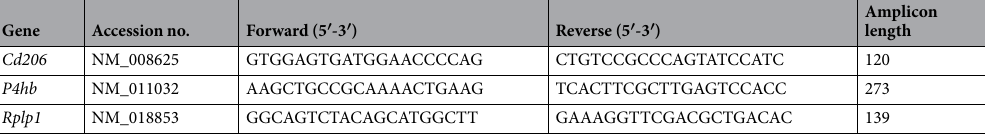
Table 2. Primer sequences a . a Primers were designed using NCBI primer BLAST and specificity confirmed using BLAST. Cd206 is also known as Mannose receptor C type 1 (Mrc1). Rplp1 , ribosomal protein large